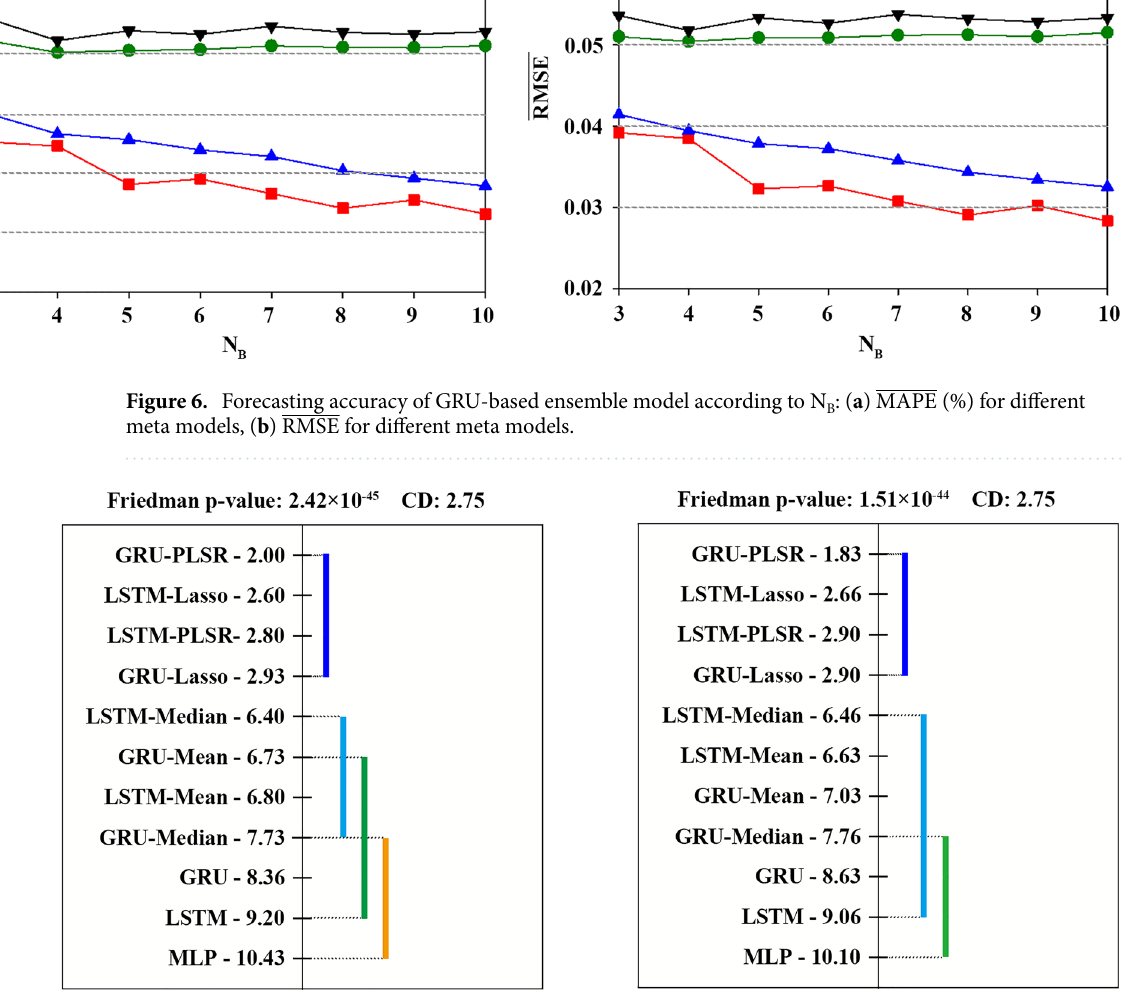
Figure 7. Nemenyi test results based on MAPE (left) and RMSE (right) for N B of 8. The critical distance (CD) is